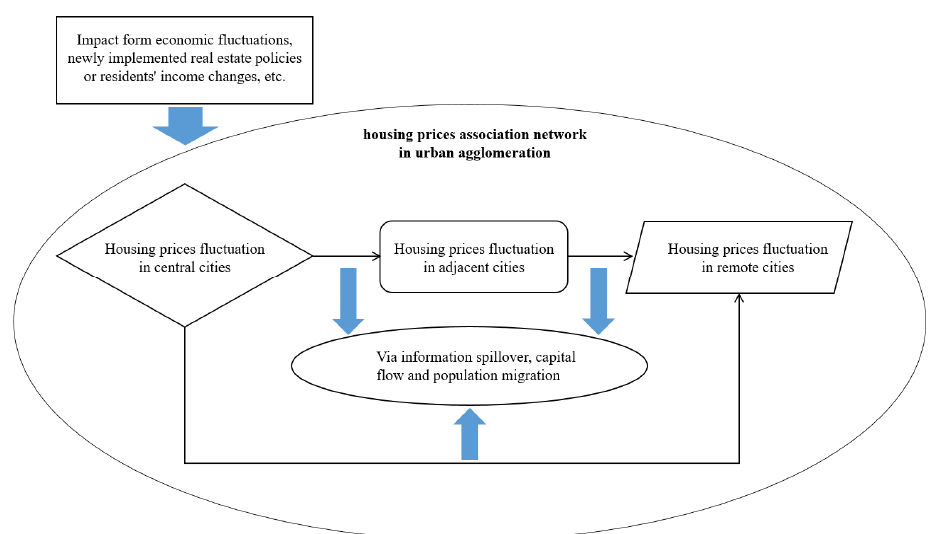
Figure 1. Mechanism of formation of a housing price association network and spillover effect in an urban agglomeration.